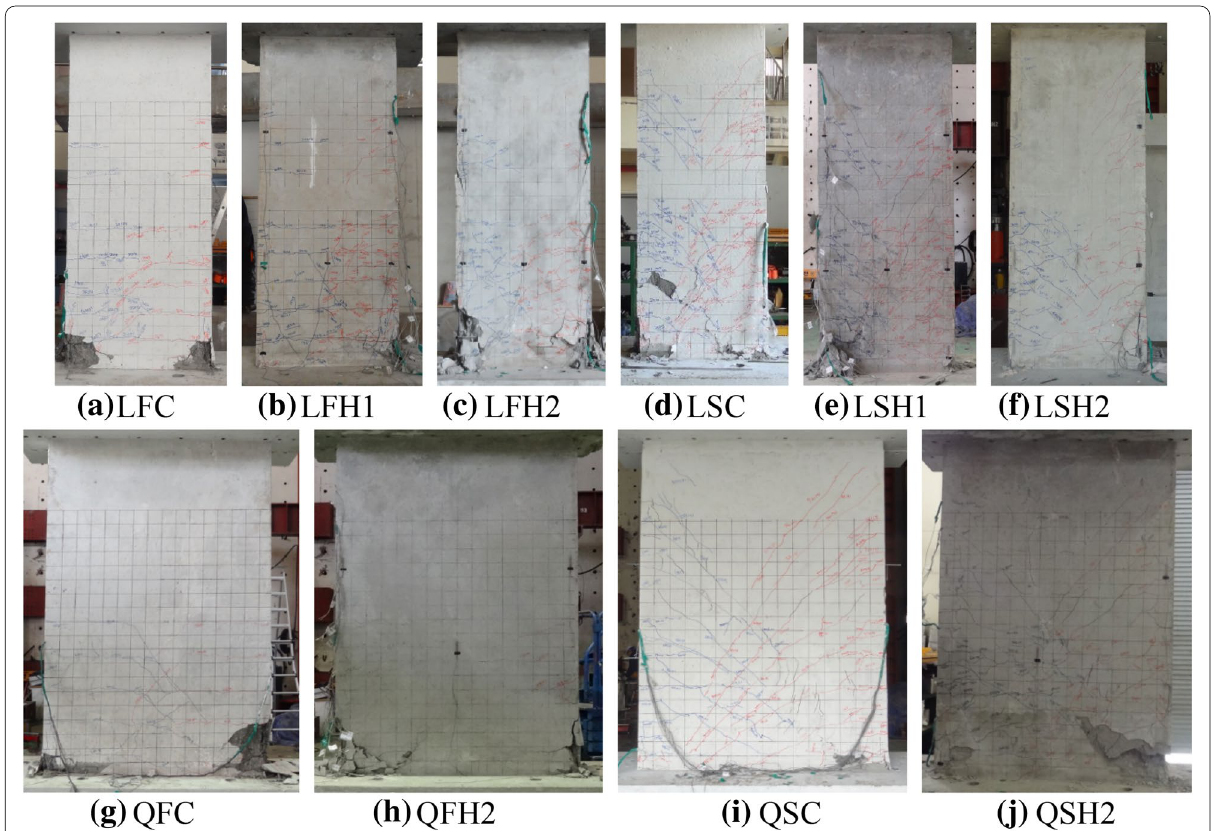
Fig. 11 Failure cracking patterns of specimens at end of